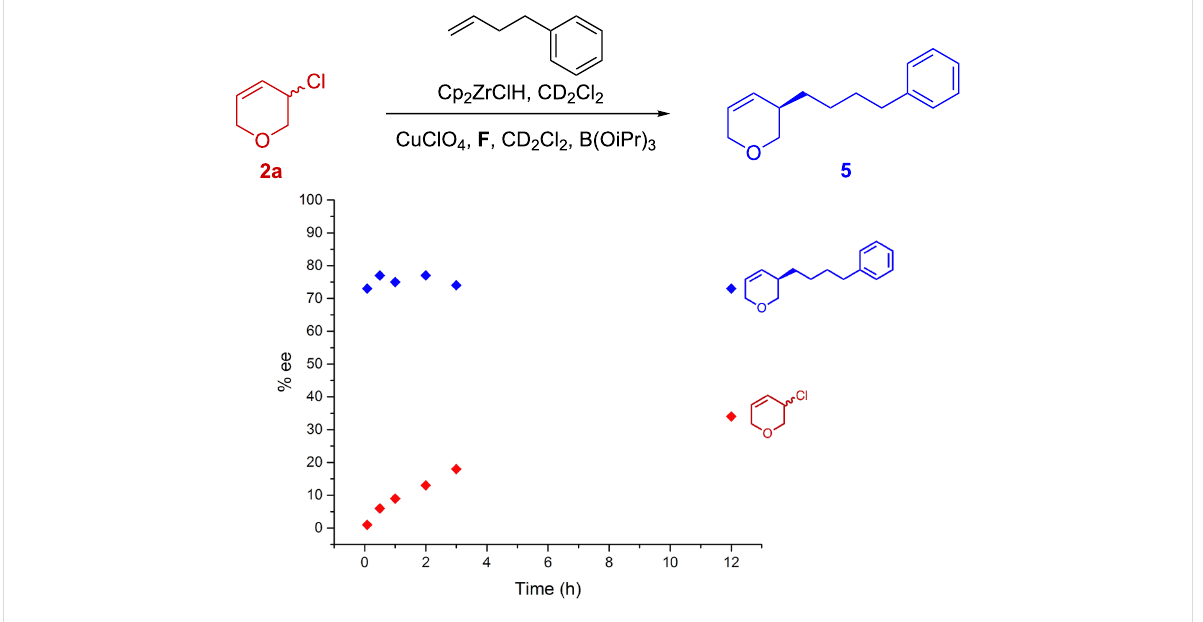
Figure 4: Kinetic ee analysis using 2a . ee of reaction with 3-chloro-3,6-dihydro-2 H -pyran ( 2a ) as measured by removing aliquots in time.